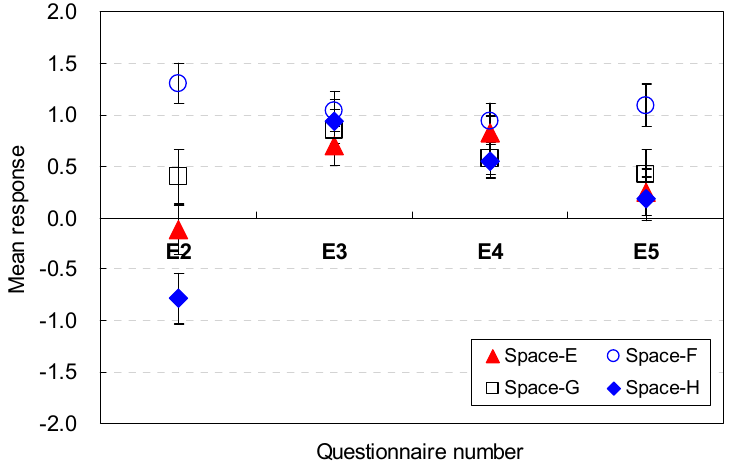
Figure 13. Spatial perception of the spatial size in terms of efficiency under floor layout changes.